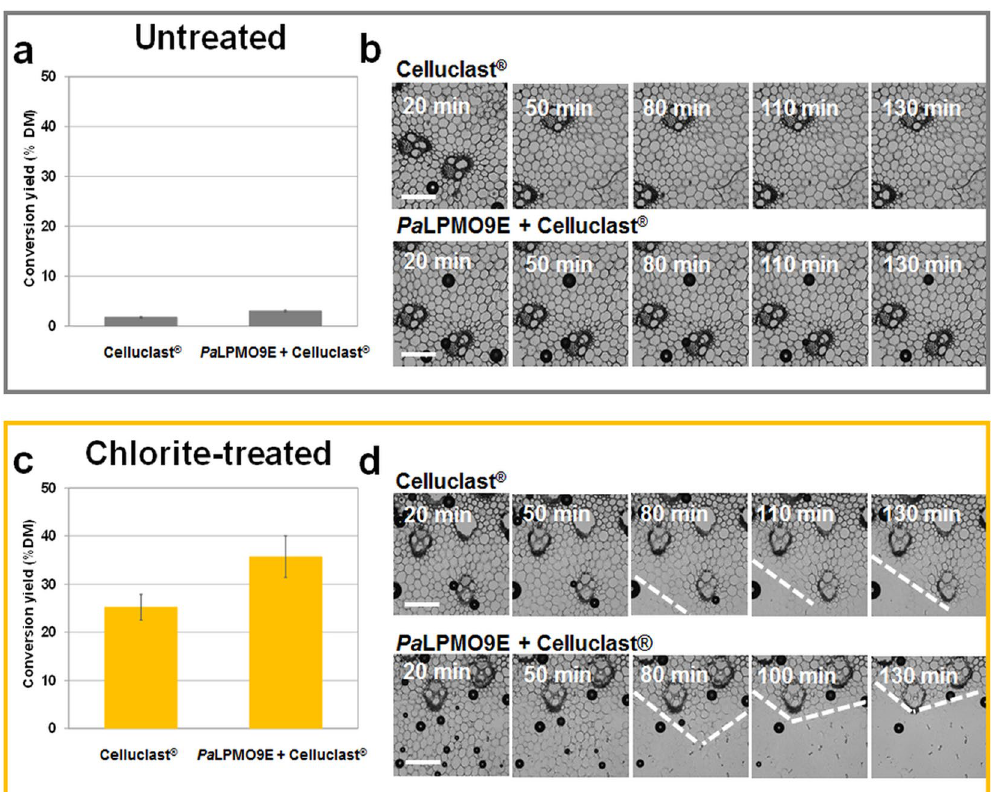
Figure 2. Effect of Pa LPMO9E on the degradation of untreated and chlorite-treated miscanthus. Enzymatic conversion of ( a ) untreated and ( c ) chlorite-treated miscanthus. Visible light time-lapse imaging of Region 2 of ( b ) untreated and ( d ) chlorite-treated miscanthus with Celluclast ® alone and Pa LPMO9E + Celluclast ® . Conversion yields are given as equivalent glucose after 72 h incubation and expressed as % dry matter. Dotted lines delineate the degraded parenchyma area region. Scale bar is 200 µ